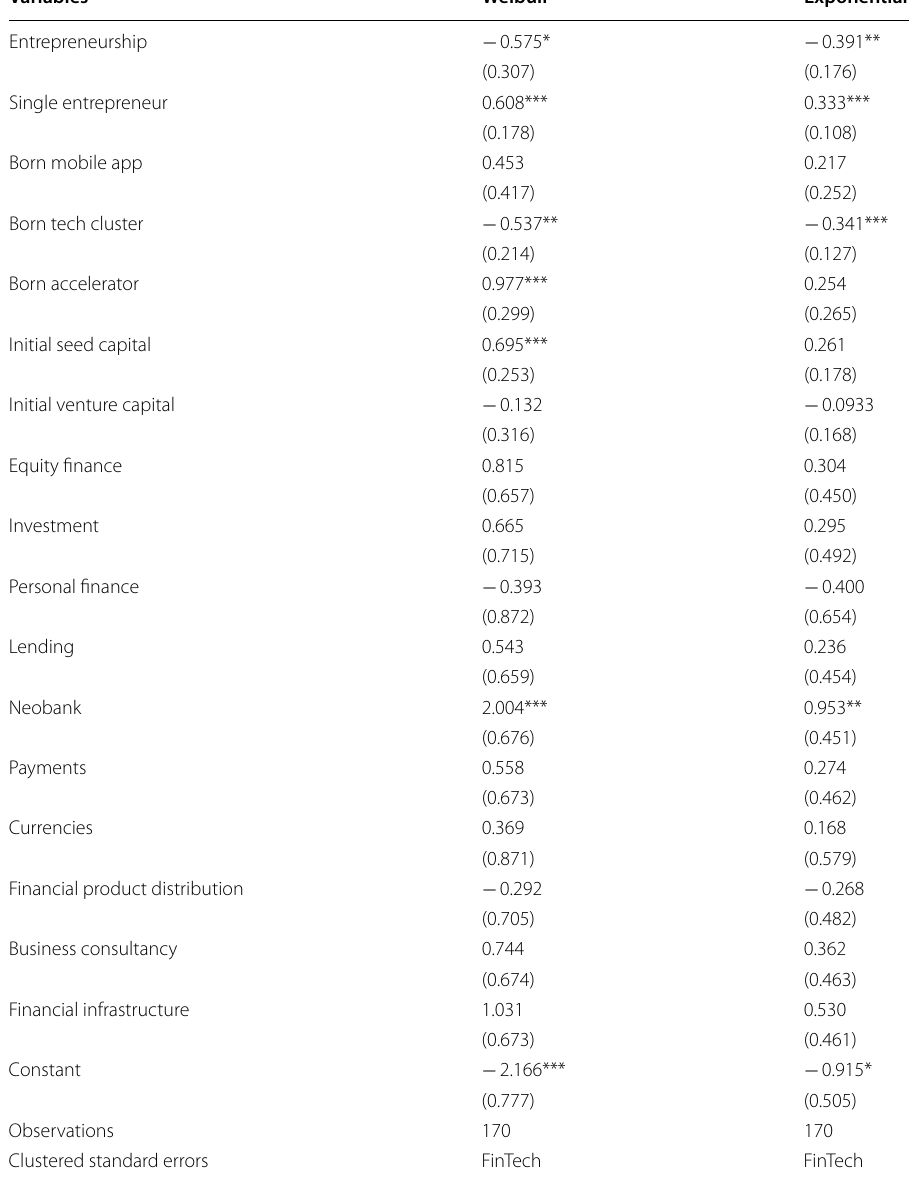
Table 14 Robustness: alternative parametric survival